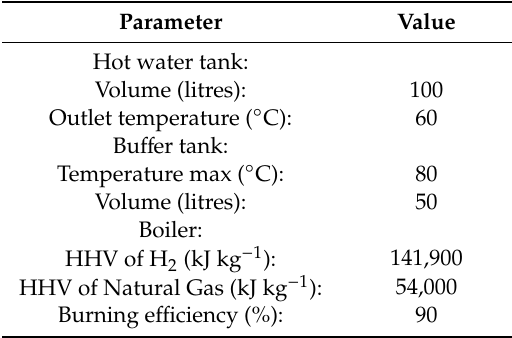
Table 3. CHP group device parameters and